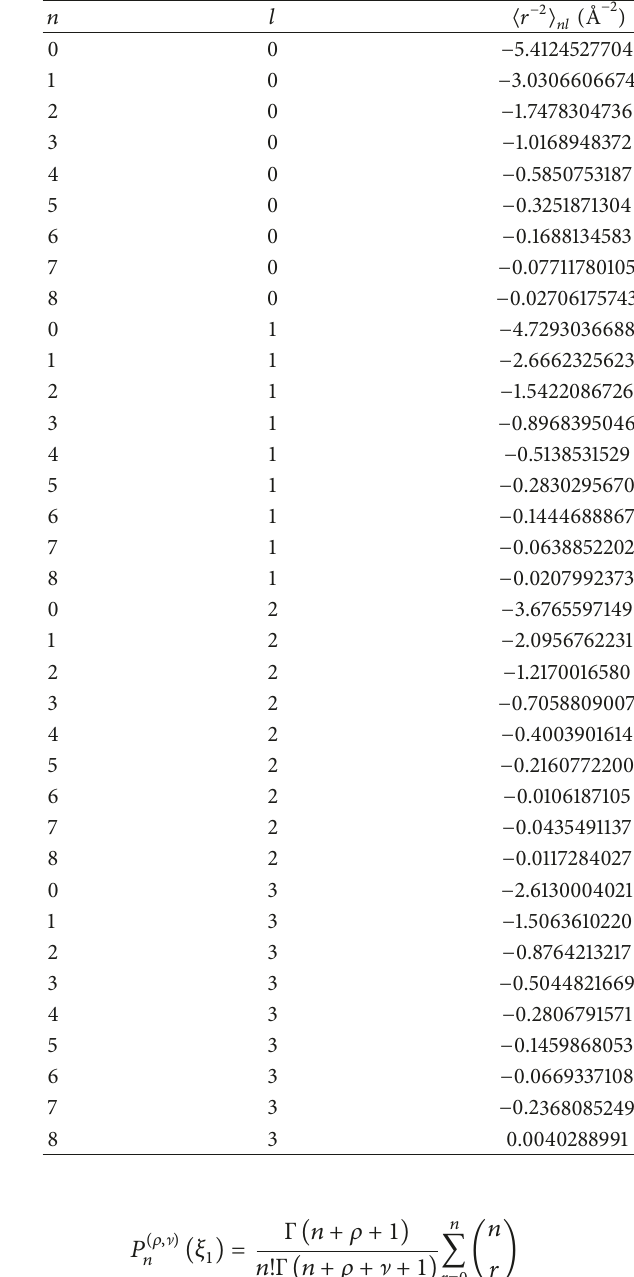
Table 4: Expectation values of ⟨𝑟 −2 ⟩ for hydrogen chloride molecule.